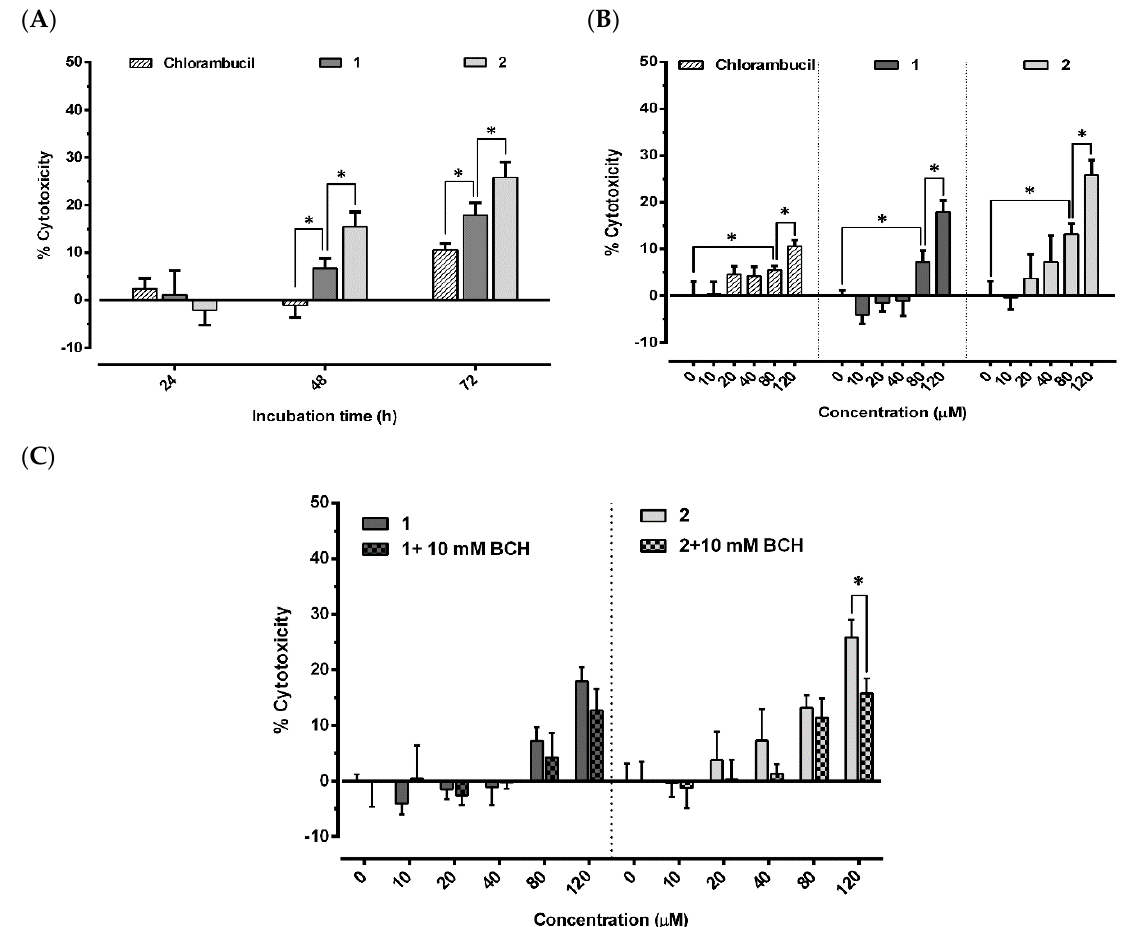
Figure 5. Antiproliferative activity of chlorambucil derivatives 1 and 2 at di ff erent incubation times (120 µ M) ( A ), di ff erent concentrations (72 h) ( B ), and di ff erent concentrations with BCH (10 mM) ( C ) in MCF-7 cells. Results expressed as mean ± SD ( n = 3). * p < 0.05, significant di ff erence compared to chlorambucil (A), untreated control (B), and co ‐ incubated with BCH (C).